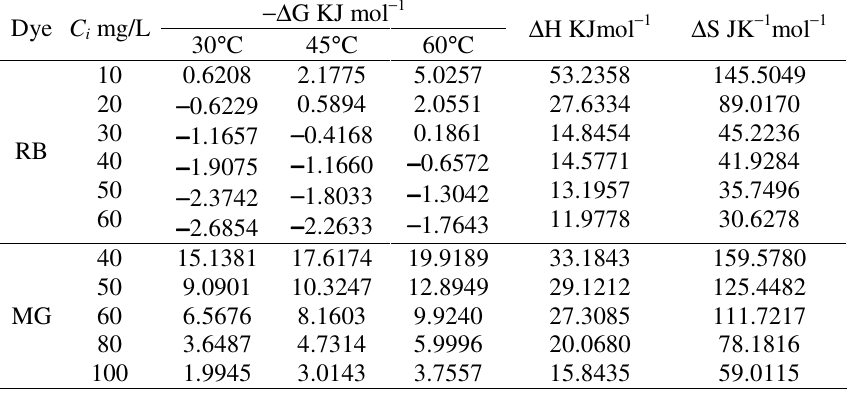
Table 8. Thermodynamic parameters for adsorption of dyes on TFC